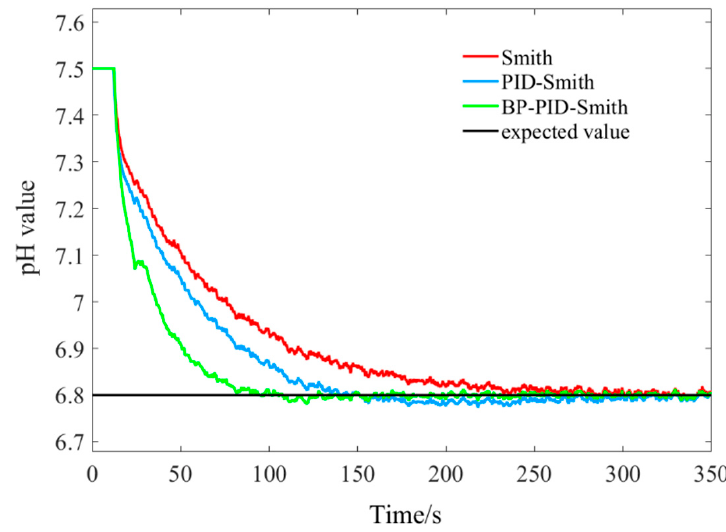
Figure 18. Regulation curves of three controllers for a fertilizer flow rate of 0.58 m 3 /h. Table 4. Comparison of the dynamic performance of the three controllers at a fertilizer flow rate of 0.58 m 3 /h.